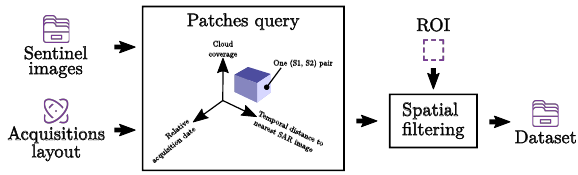
Figure 8. Workflow for the creation of datasets. The sample query use a R-Tree indexing the available Sentinel-1 and Sentinel-2 images patches.